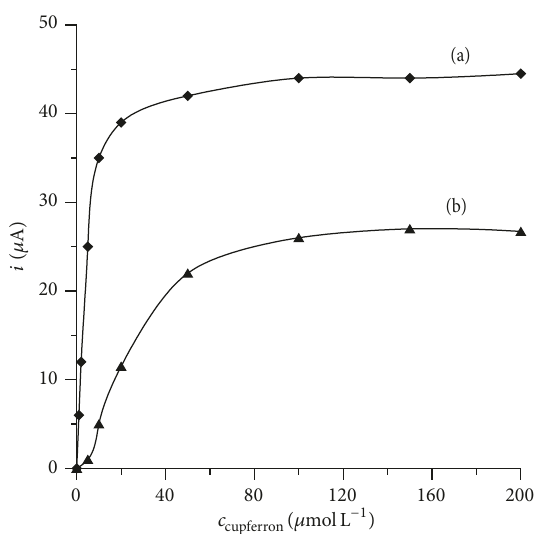
Figure 1: The influence of cupferron concentration on the 2 × 10 −8 molL −1 Bi(III) (a) and 2 × 10 −8 molL −1 Pb(II) (b) peak current. Accumulation potential − 0.05 V and accumulation time 30 s. pH acetate buffer equal to 4.5.